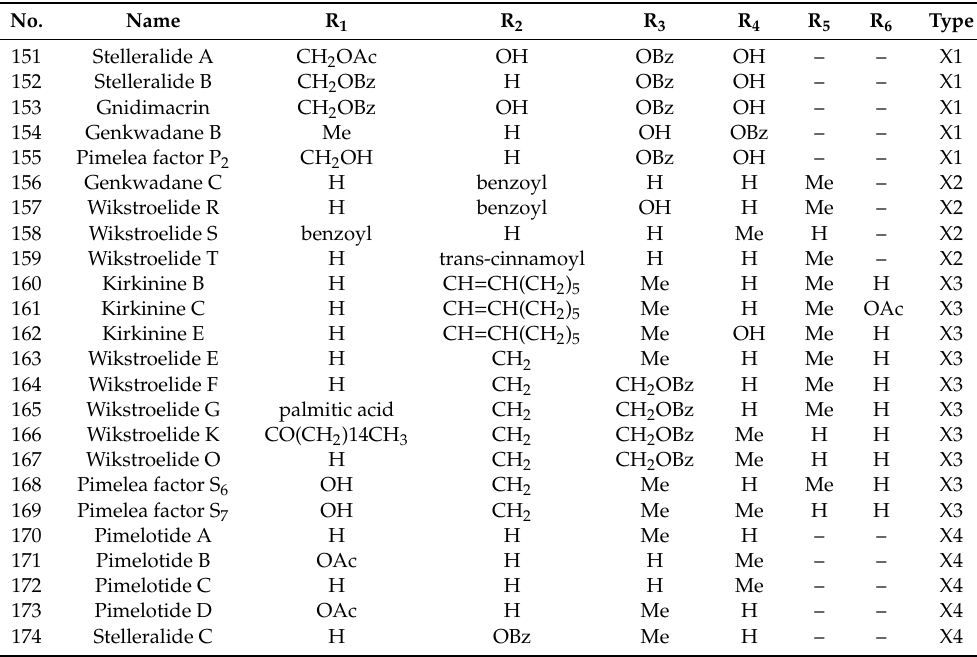
Figure 5. Four types ( X1 – X4 ) of 1-alkyldaphnanes skeletons. Table 5. Reported structures of 1-alkyldaphnanes skeletons.